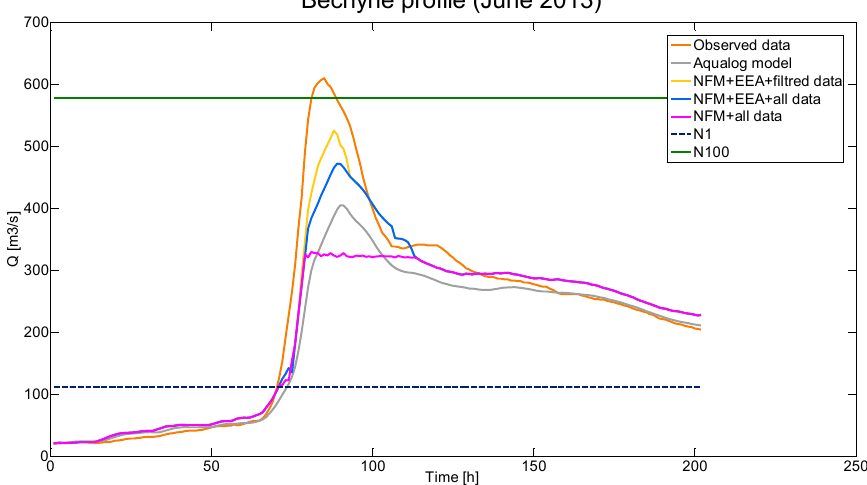
Figure 7. Results for the selected episode in the Bechynˇe profile. Figure 7 shows the course of the selected episode, where the dashed blue line shows the flow value N1 (period of return = 1) and the green value N100 (period of return = 100). The measured data are plotted in orange. The re-simulation of the episode using the Aqualog model is shown in gray. The results are shown in pink with the use of post-processing without the use of the EEA algorithm and the selection of episodes was not used during the training. The results of post-processing using the EEA algorithm during training and without selection of individual episodes are displayed in blue. The yellow color shows the results using post-processing using the EEA algorithm during training and using the selection of episodes.